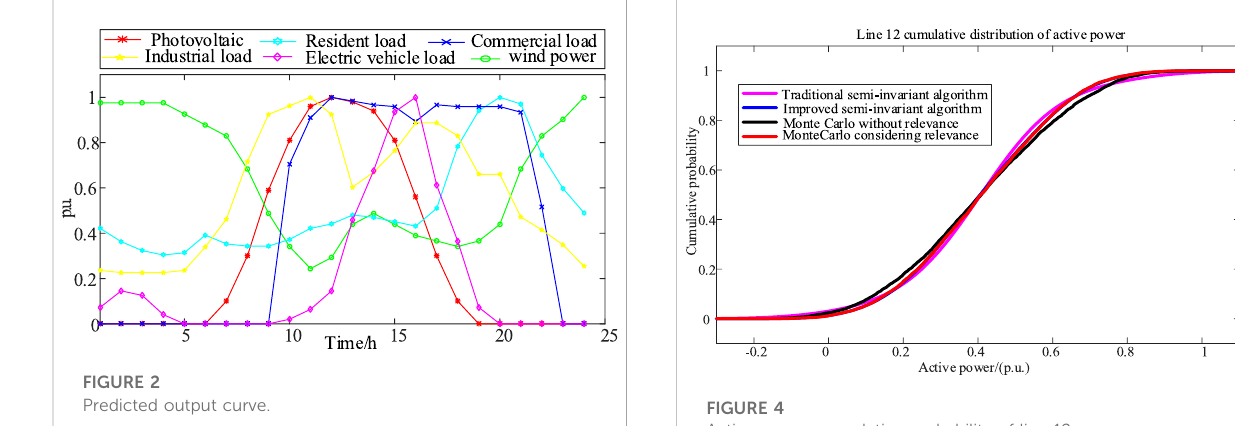
FIGURE 4 Active power cumulative probability of line